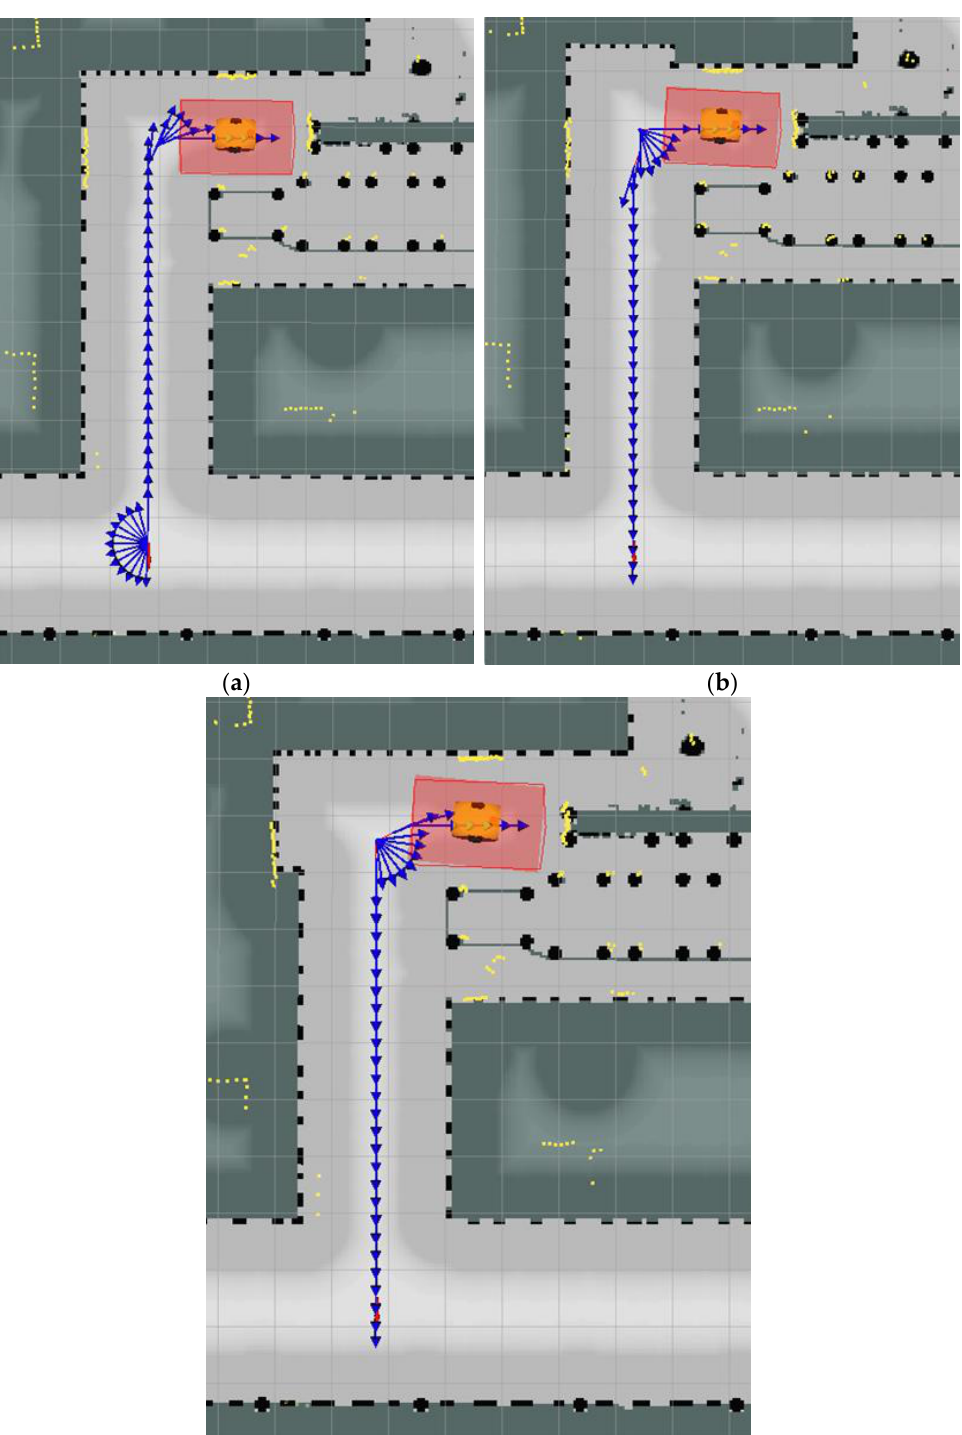
Figure 8. Calculated paths for AMR starting from the dock position (at the top) to destination pose (at the bottom) on the original occupancy grid ( a ) and on modified occupancy grid ( b , c ). In addition to the front and rear safety laser scanners, the prototype robot was equipped with a stereo vision (3D) camera and a high-resolution (2D) camera, which were mounted only at the front of the vehicle—Figure 4. The 3D camera allowed the robot to detect objects in front of it, also those “invisible” to the front security scanner